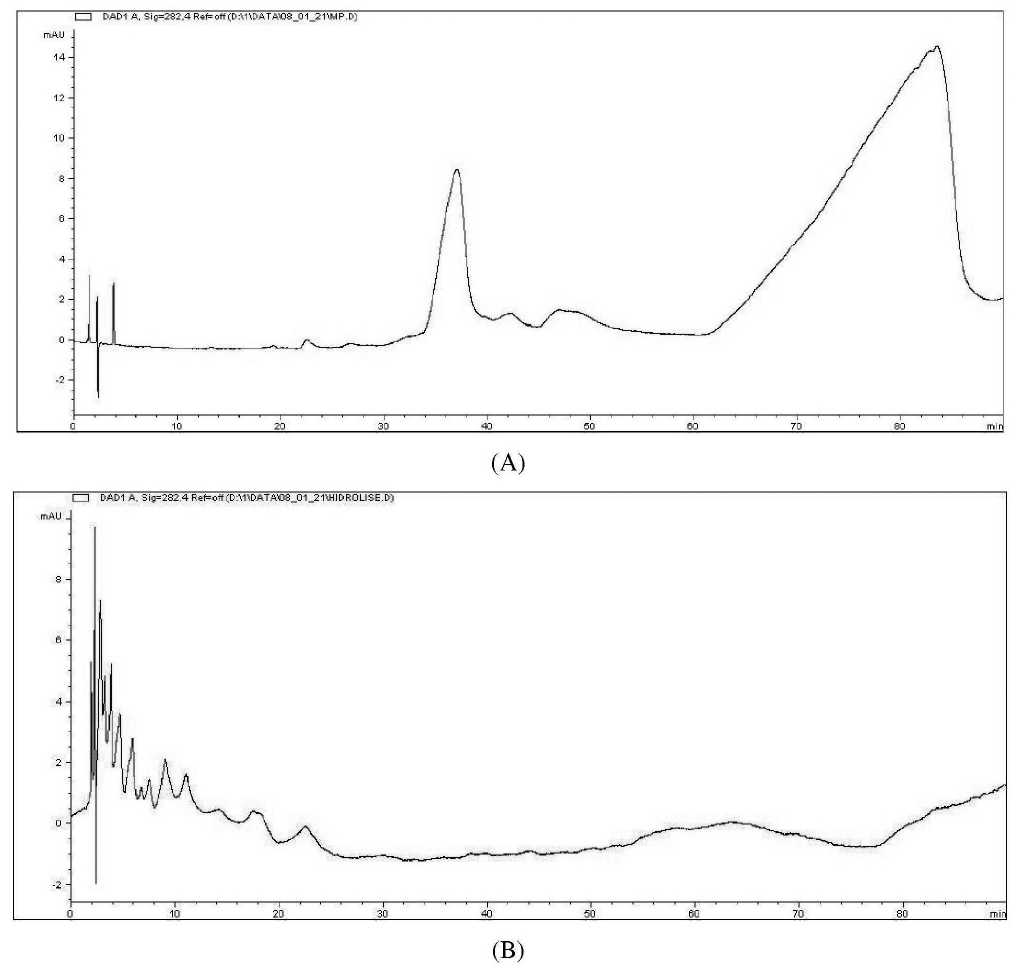
FIGURE 2 - Chromatogram obtained through analysis of raw material (A) and degradation product (B) of gramicidin using HPLC method.